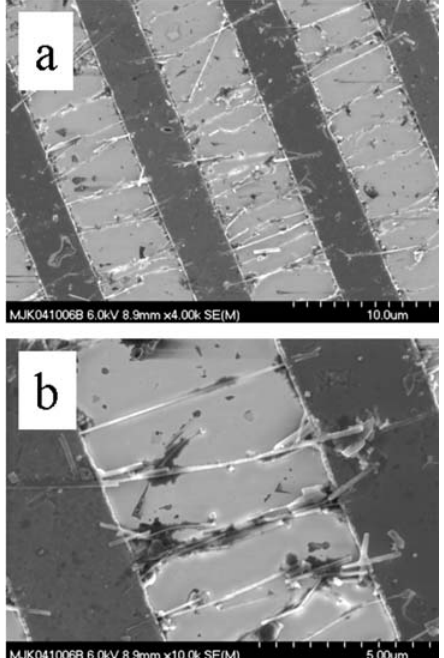
Figure 17. SEM images illustrating more homogeneous dispersion and alignment by E- field induced torque in concert with dielectrophoresis. Purification aids the uniformity of the deposited material.